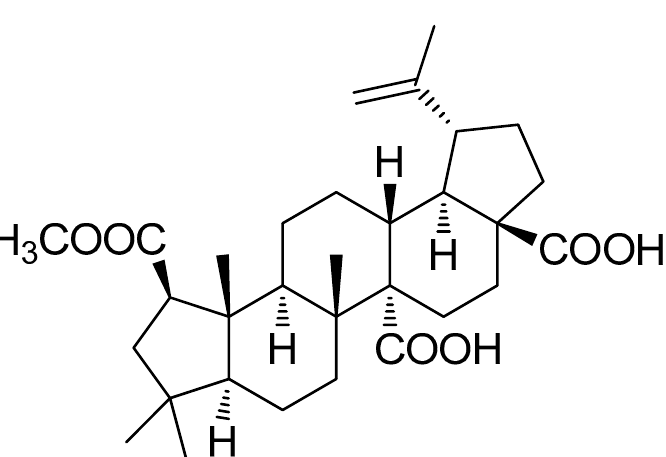
Figure 1. Chemical structure of 3DC2ME isolated from Ziziphus jujuba .